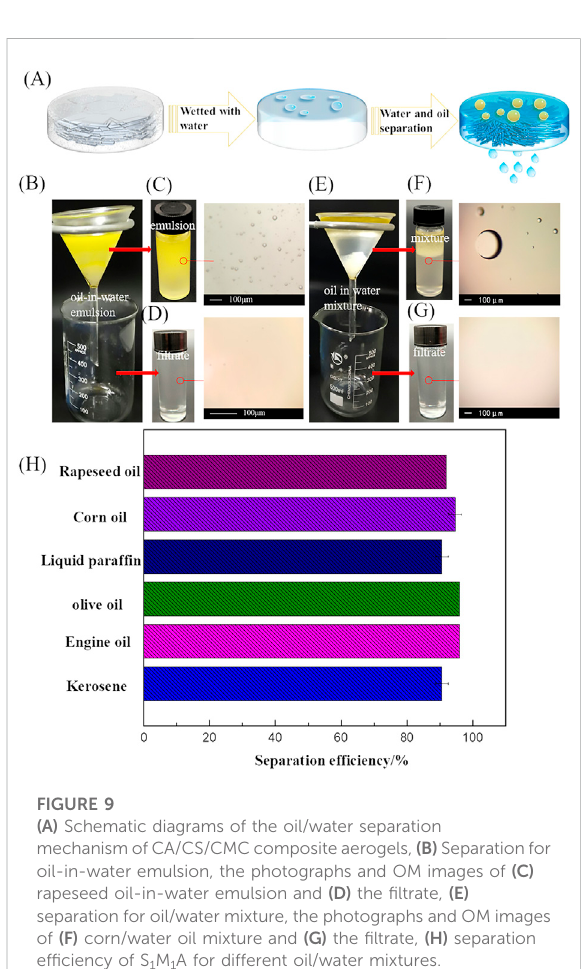
FIGURE 9 (A) Schematic diagrams of the oil/water separation mechanism ofCA/CS/CMCcompositeaerogels, (B) Separationfor oil-in-water emulsion, the photographs and OM images of (C) rapeseed oil-in-water emulsion and (D) the fi ltrate, (E) separation for oil/water mixture, the photographs and OM images of (F) corn/water oil mixture and (G) the fi ltrate, (H) separation ef fi ciency of S 1 M 1 A for different oil/water